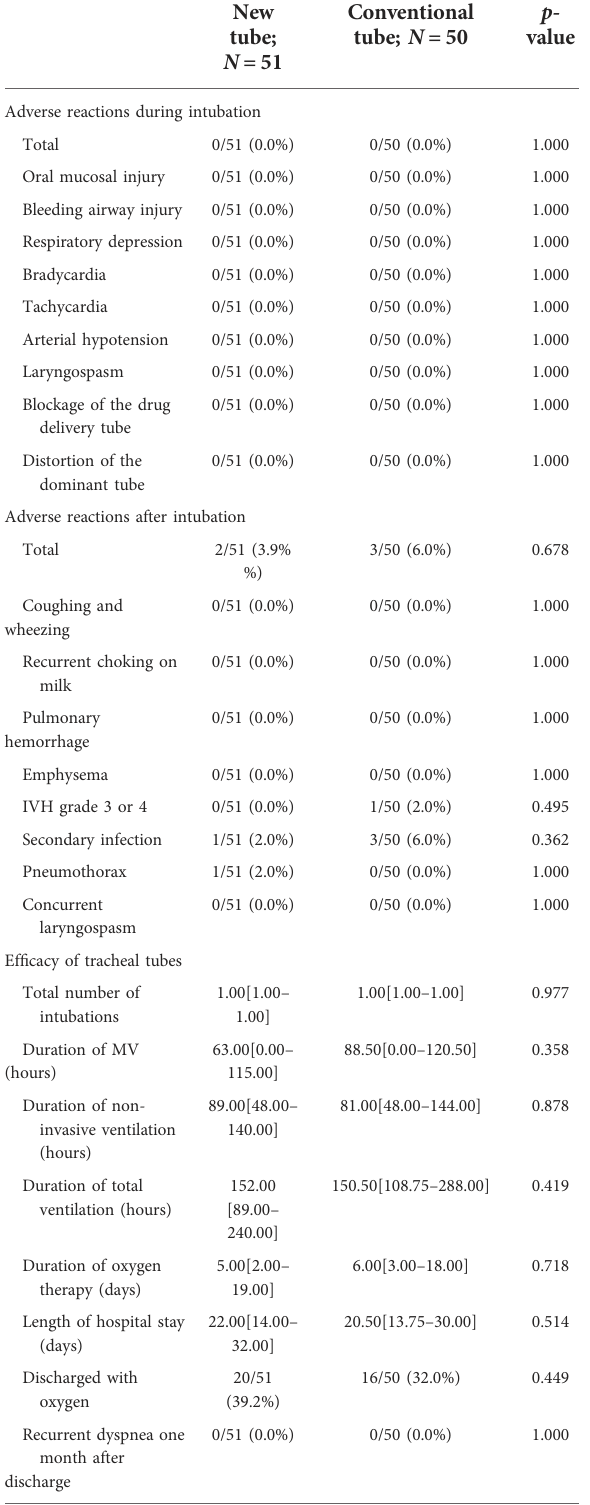
TABLE 7 Clinical outcomes of neonates with the new or conventional tracheal